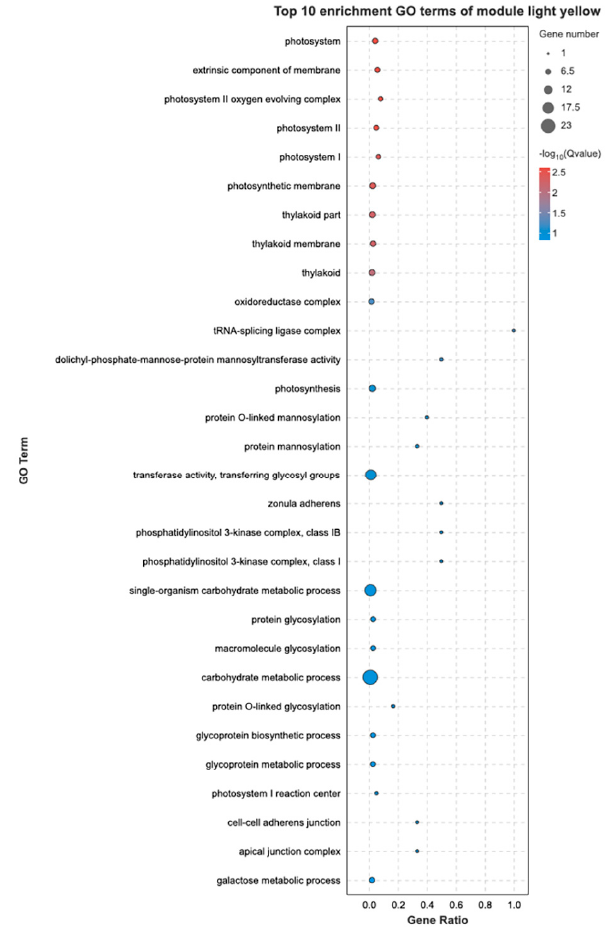
Figure 7. DEGs common to the two comparison groups (CK vs. >0 °C or <0 °C treatment) according to KEGG pathway analysis.